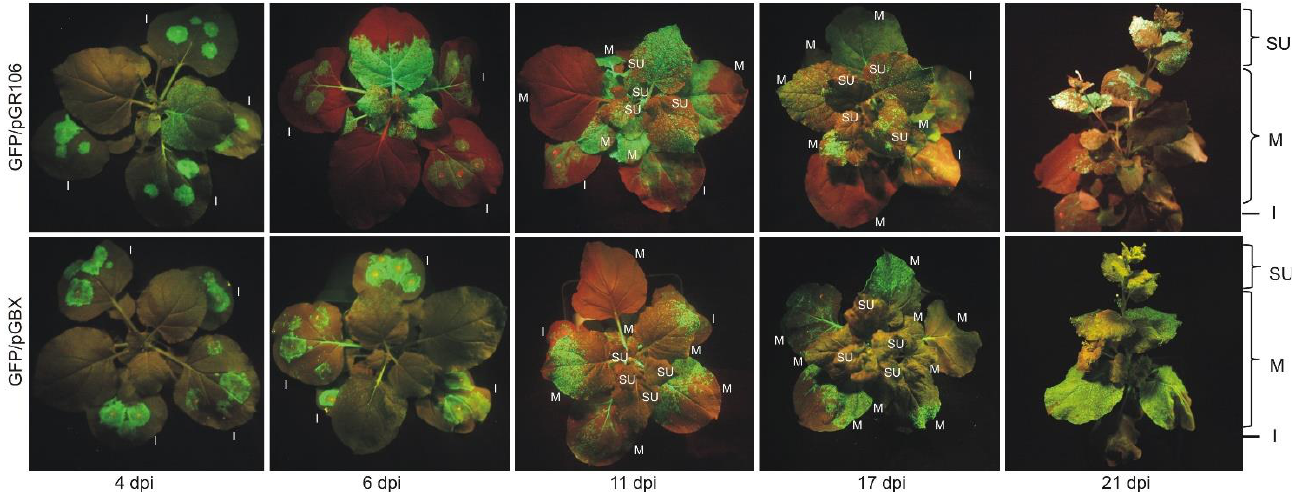
Figure 2. GFP expression in N. benthamiana plants visualized under UV light. Systemic infection of GFP/pGBX plants is delayed by 2 days (at 6 dpi) compared to GFP/pGR106 plants (4 dpi). Over time, the GFP/pGBX vector accumulated GFP mainly in the middle part of the plant, whereas GFP expression in GFP/pGR106 plants progressed throughout the plant to the SU leaves. Photographs were taken at 4, 6, 11, 17, and 21 dpi, respectively. Representative photos for GFP/pGR106 and GFP/pGBX plants were selected. The data shown on the right (I, M, SU) represent the distribution of the evaluated plant parts; dpi, days post-inoculation; I, inoculated leaves; M, systemic middle leaves; SU, systemic four upper leaves.